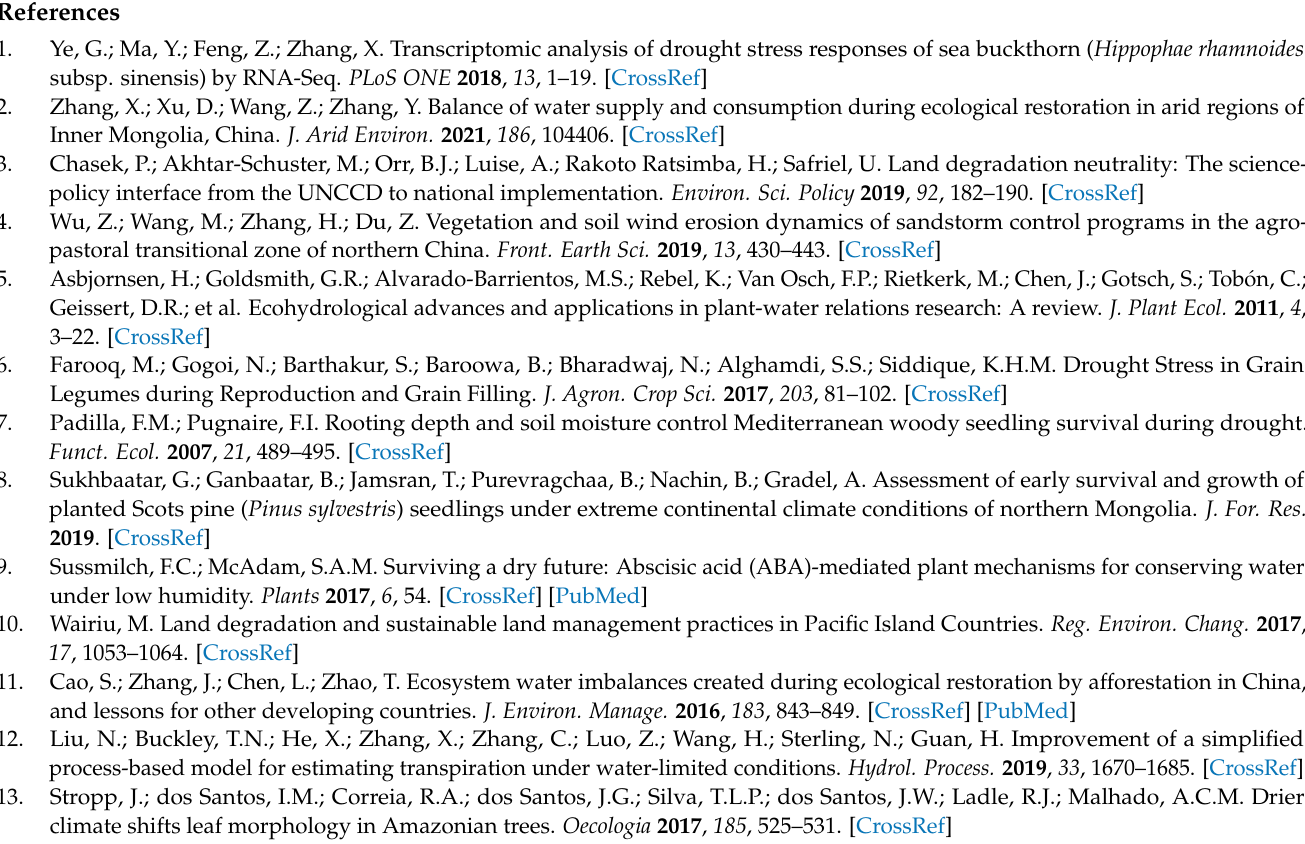
Table S1: Annual root collar diameter growth (RCD) and height of Tamarix ramosissima , Ulmus pumila , Elaeagnus moorcroftii , and Hippophae rhamnoides across treatments measured from 2009 to 2019; Table S2: p values estimated by two-way analysis of variance (ANOVA) for RCD and height growth across treatments and species; Table S3: Repeated measures analysis of variance for transformed heights and RCD from all measurement